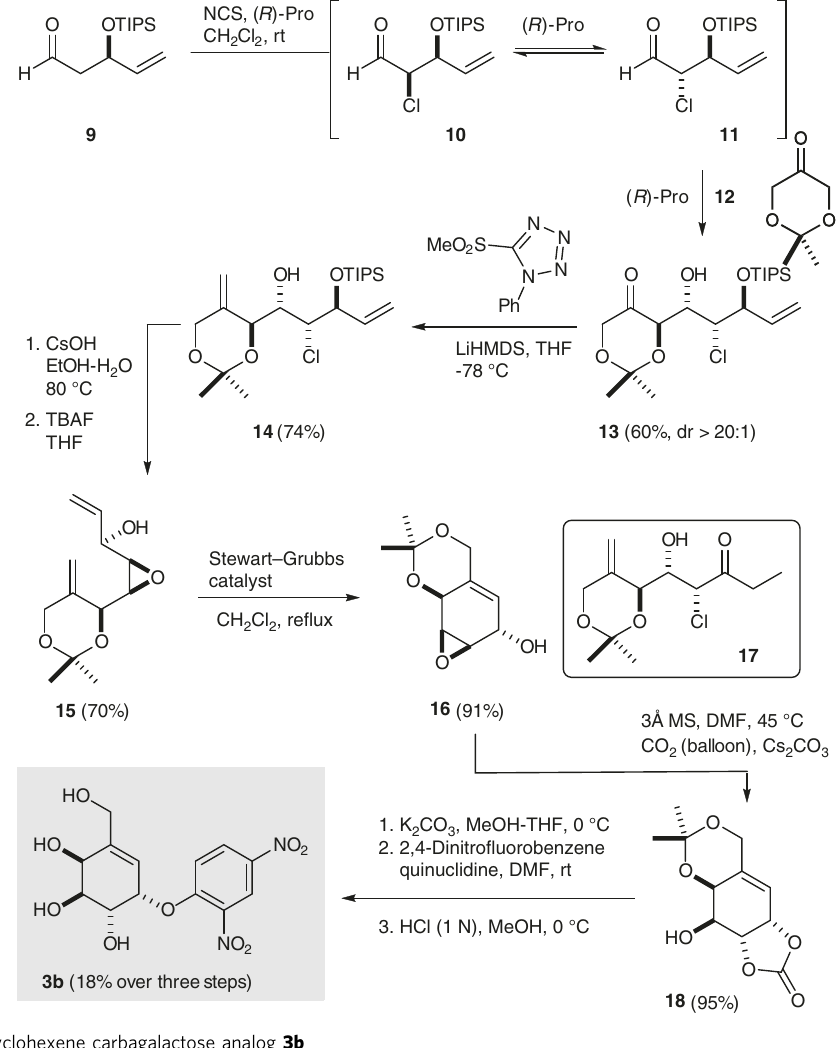
Fig. 3 Synthesis of the cyclohexene carbagalactose analog